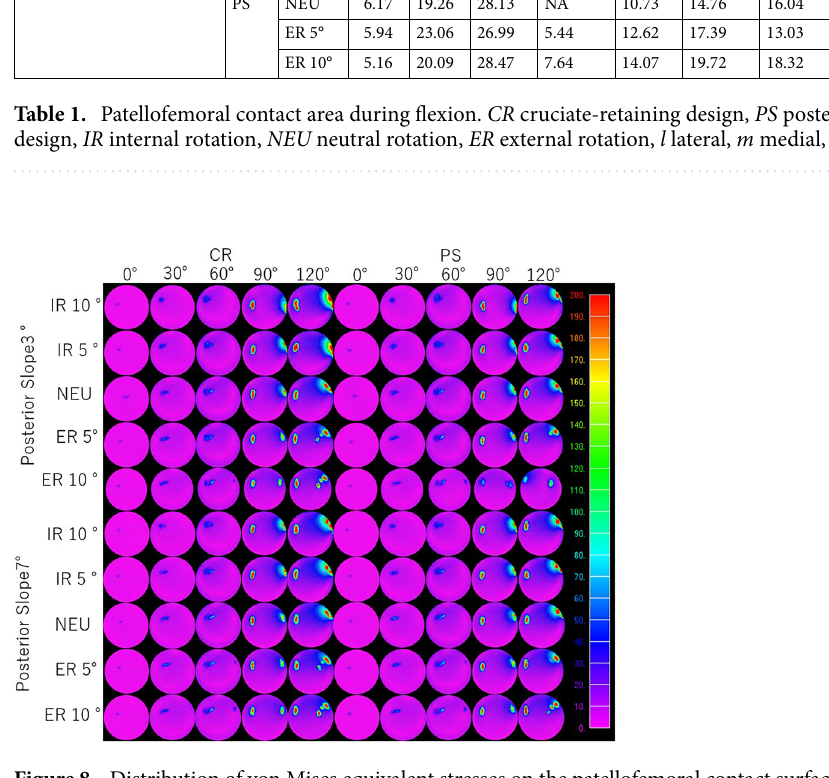
consistent with Sharma’s analysis of PF contact forces based on in vivo fluoroscopy, which reported lower PF contact forces for the PS design compared to the CR design 34 . PF contact forces can be clinically relevant. Kaneko et al. found a negatively correlation between intraoperative compressive force across the PF joint at 140°of flexion and patient satisfaction and Forgotten Joint Score-12 10 . PF stresses followed a trend similar to PF contact forces and peak von Mises stresses increased with knee flexion. Overall, there were minimal difference in PF stresses between CR and PS designs except when a PTS of 3° was combined with internal rotation of tibial component. The higher patellar stresses in the CR design at 3° could be related to the magnitude of femoral rollback. Increases in PTS contributed to a more posterior position of the femoral component (Fig. 3) which was associated with lower PF force (Fig. 4). Studies have found that greater PTS can protect the PCL by reducing posterior tibial translation in chronically injured PCL knees 35,36 . Our findings are also consistent with cadaver experiments that reported lower PF contact pressure in PS designs compared